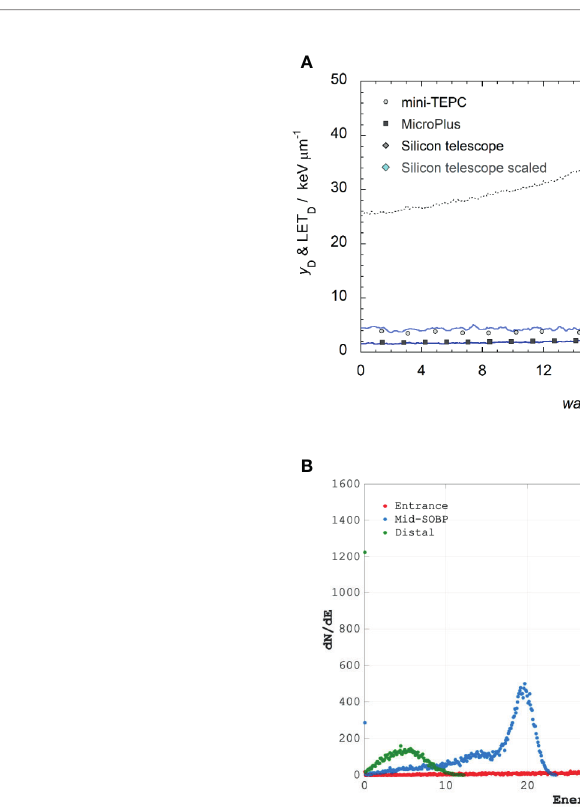
FIGURE 1 | Top panel (A) : The LET-dose primary computed for only primary protons (blue line) and LET-dose total calculated considering also the contribution of generated secondary particles (indigo line) are reported. The dotted line represents the dose values measured in a water phantom with the Markus Chamber (mod. 3002). Experimental y D values are obtained with the mini-TEPC (gray circles), MicroPlus (black squares), Silicon telescope (gray diamonds). Light blue diamonds represent the silicon data multiplied by a factor k=0.65. Bottom Panel (B) : Incident proton energy distribution corresponding to the positions where cells were placed as calculated by Hadrontherapy Geant4 advanced